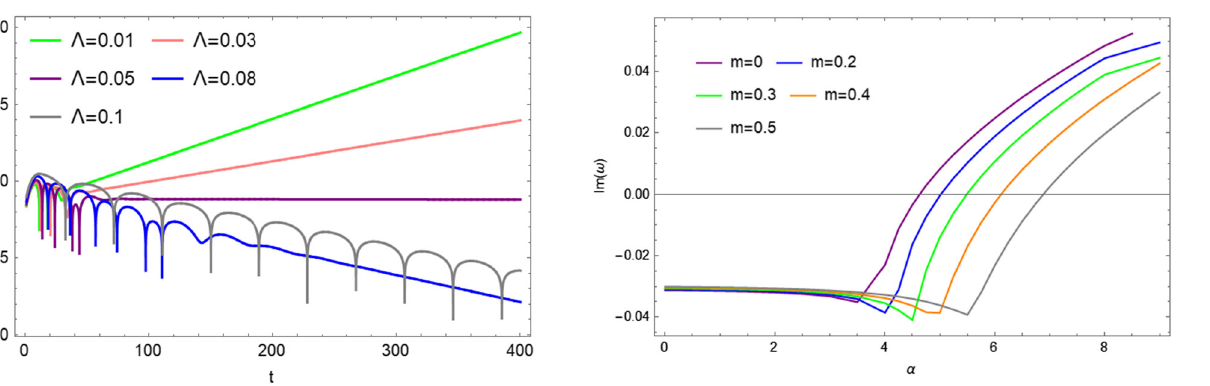
Fig. 7 The fundamental QNM frequency for (cid:4) = 1 mode as a